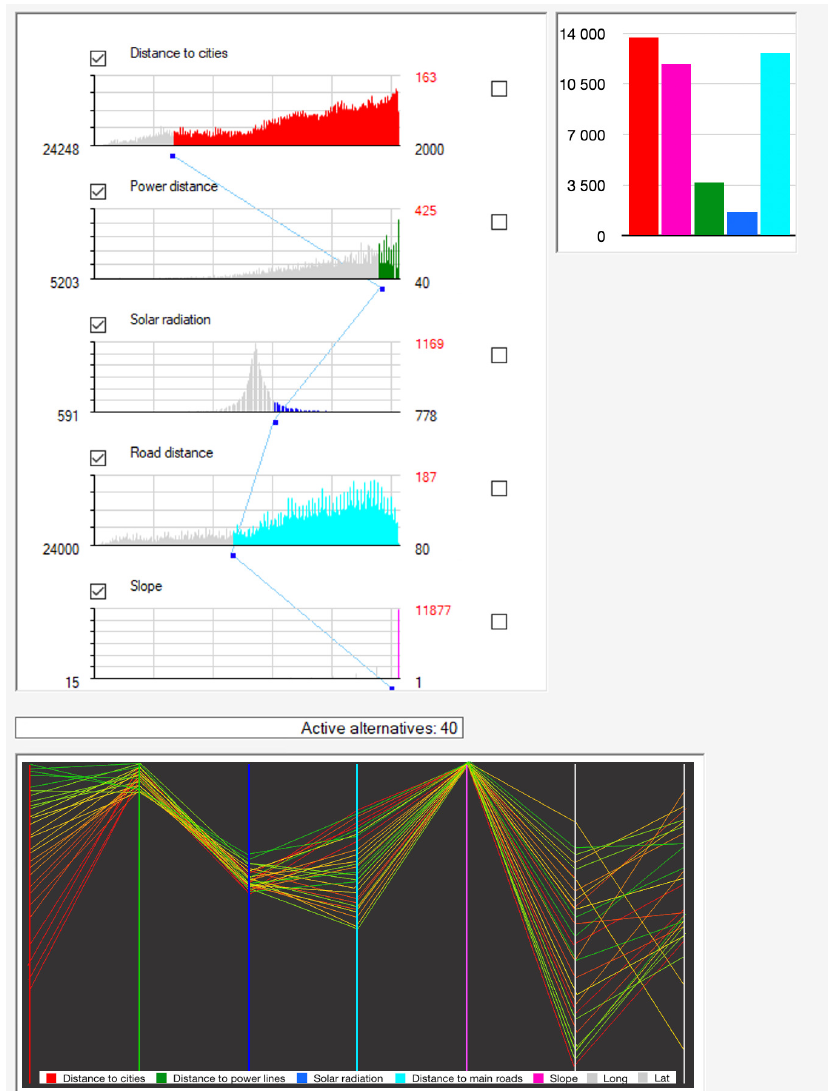
Figure 7. Each of the five coloured axes in the parallel coordinates plot holds the values of the remaining acceptable alternatives in terms of one of the criteria. The last two axes represent longitude and latitude of the alternatives in the geographical space. Polylines representing the alternatives are colour-coded from green (best) to red